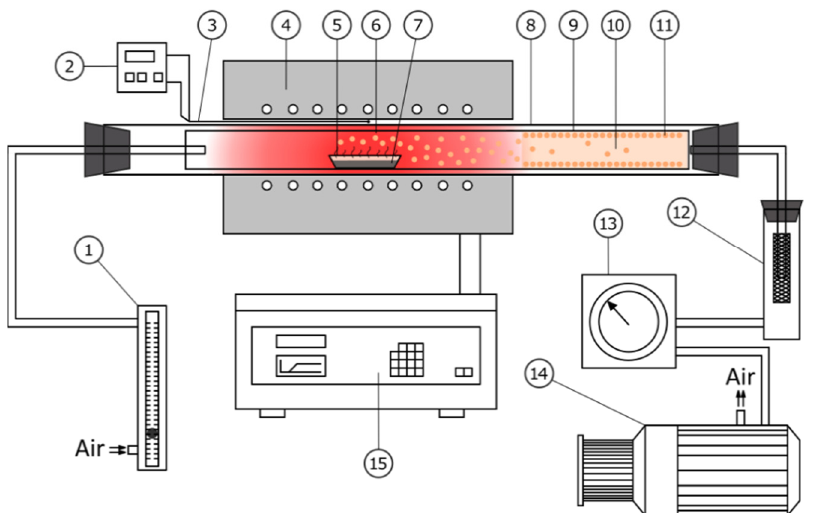
Figure 2. Horizontal vacuum unit with a split condenser: (1) rotameter, (2) temperature controller in the reaction zone, (3) control thermocouple, (4) electric furnace, (5) boat, (6) isothermal zone, (7) sample, (8) reactor, (9) split condenser, (10) condensation zone, (11) condensate, (12) filter, (13) barometer-aneroid, (14) vacuum pump, and (15) furnace controller.